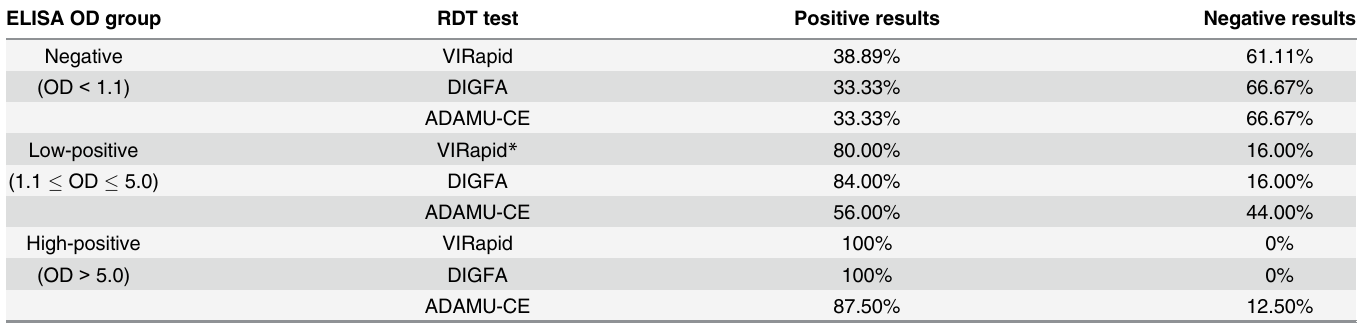
Table 3, we found that for all RDTs the percentage of positive results increased passing from negative to low-positive to high-positive ELISA OD groups, with discrepancies between ELISA